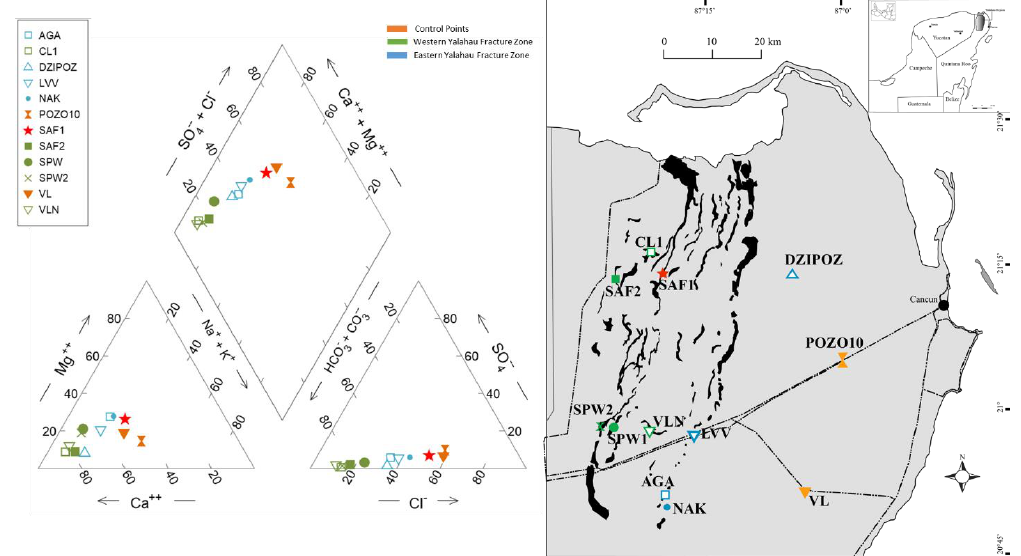
Figure 2. Piper diagram of Yalahau region sites indicating bulk water composition of water samples from sampling sites with adjacent site map. Site symbols correlate to the Piper